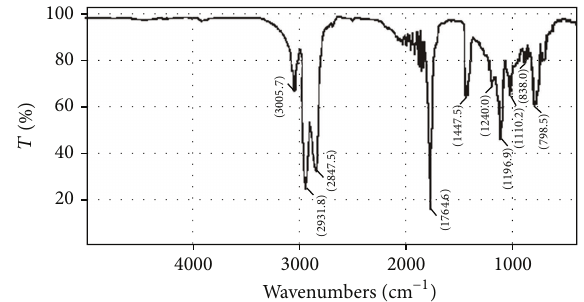
Figure 3: A typical FTIR spectrum of palm oil based